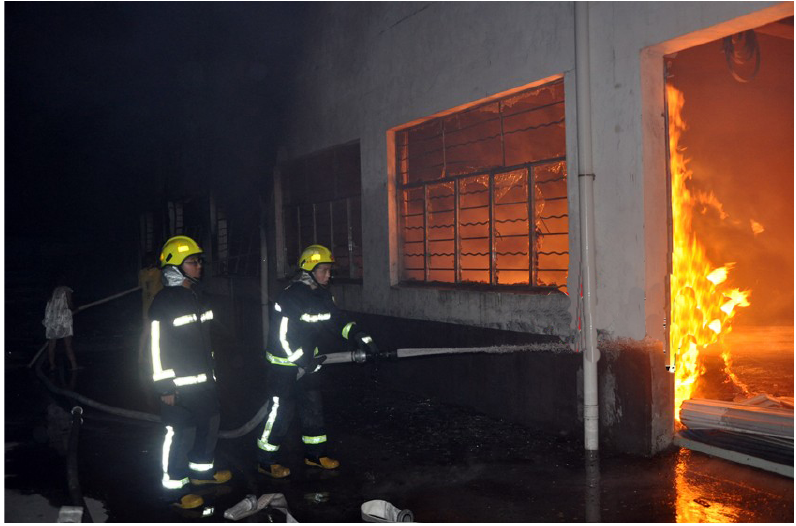
Figure 9. The fire rescue is continuing (picture source: [24]).